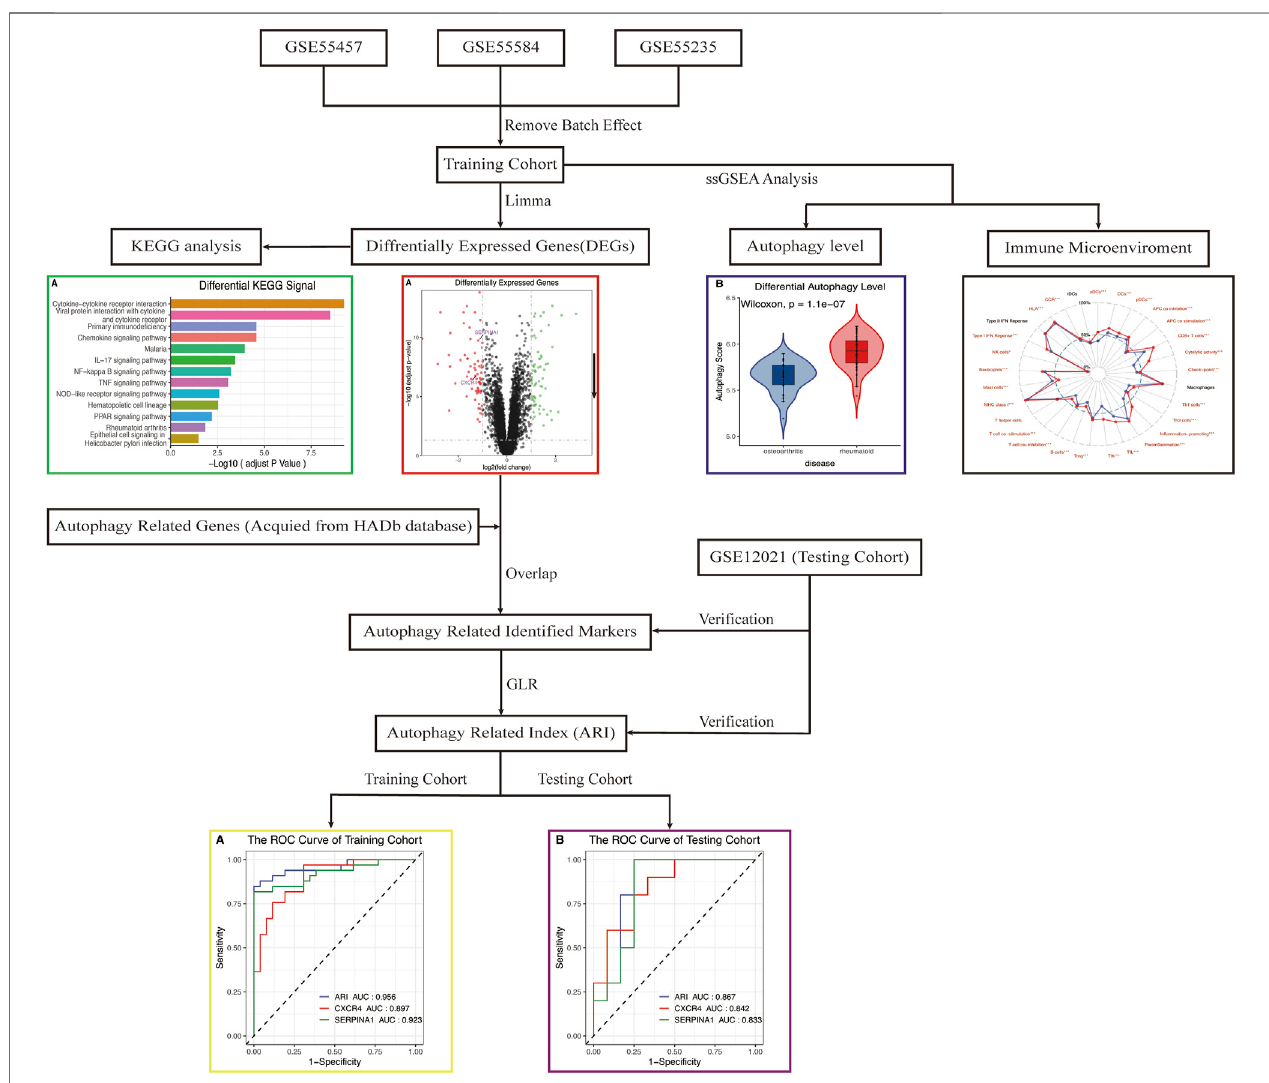
FIGURE1| Flowchartoftheanalysis.DEGs,differentiallyexpressedgenes;KEGG,KyotoEncyclopediaofGenesandGenomes;ssGSEA,single-samplegene-set enrichment analysis; ARI, autophagy-related index; GLR, generalized linear regression; ROC, receiver operating characteristic.